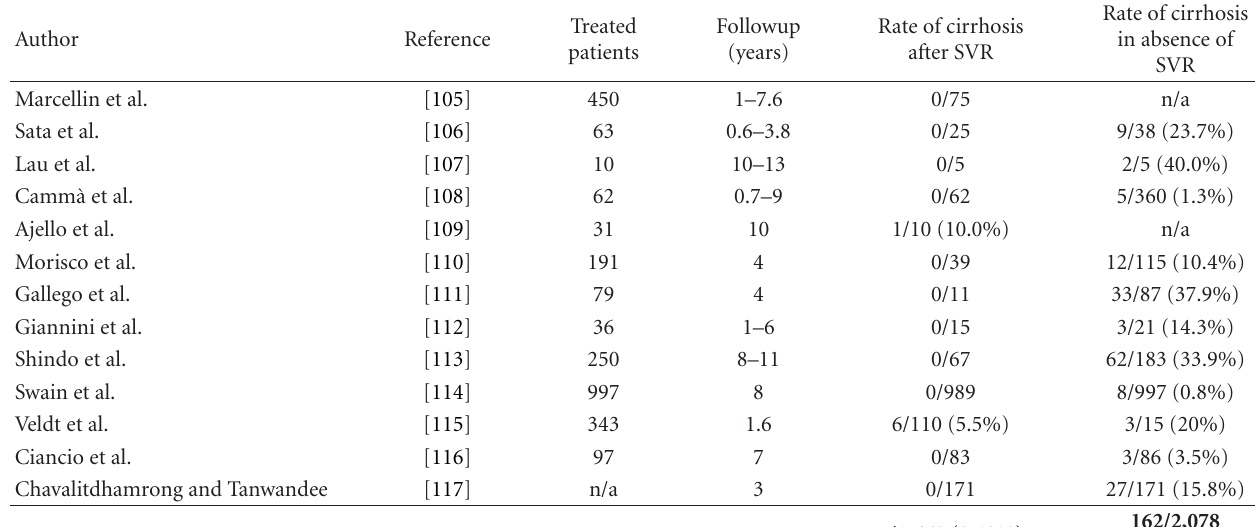
Table 1: Cumulative rate of development of cirrhosis in patients with HCV-related chronic hepatitis according to sustained viral response (SVR); n/a: not